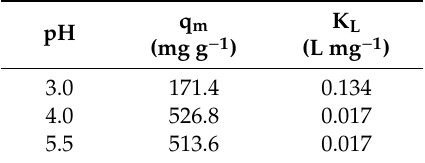
Table 8. pH dependence of the Langmuir parameters for the sorption of norfloxacin onto HA (adapted from